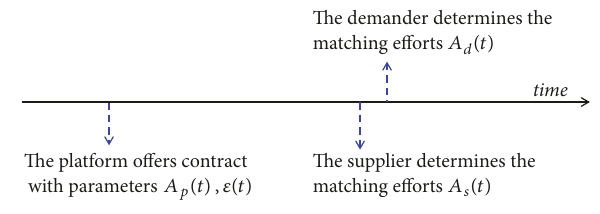
Figure 4: Sequence of the events under the coordination-contract